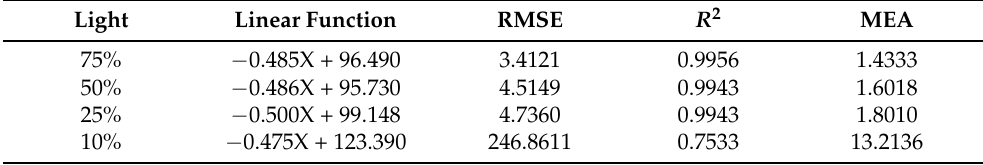
Table 12. The effect of ambient light on the performance; the results are presented for an urban location, from an altitude of 200 m, under various lighting conditions (ranging from 75 to 10% light). Light Linear Function RMSE R 2 MEA 75% − 0.226X + 98.867 1.3956 0.9981 0.9657 50% − 0.231X + 99.090